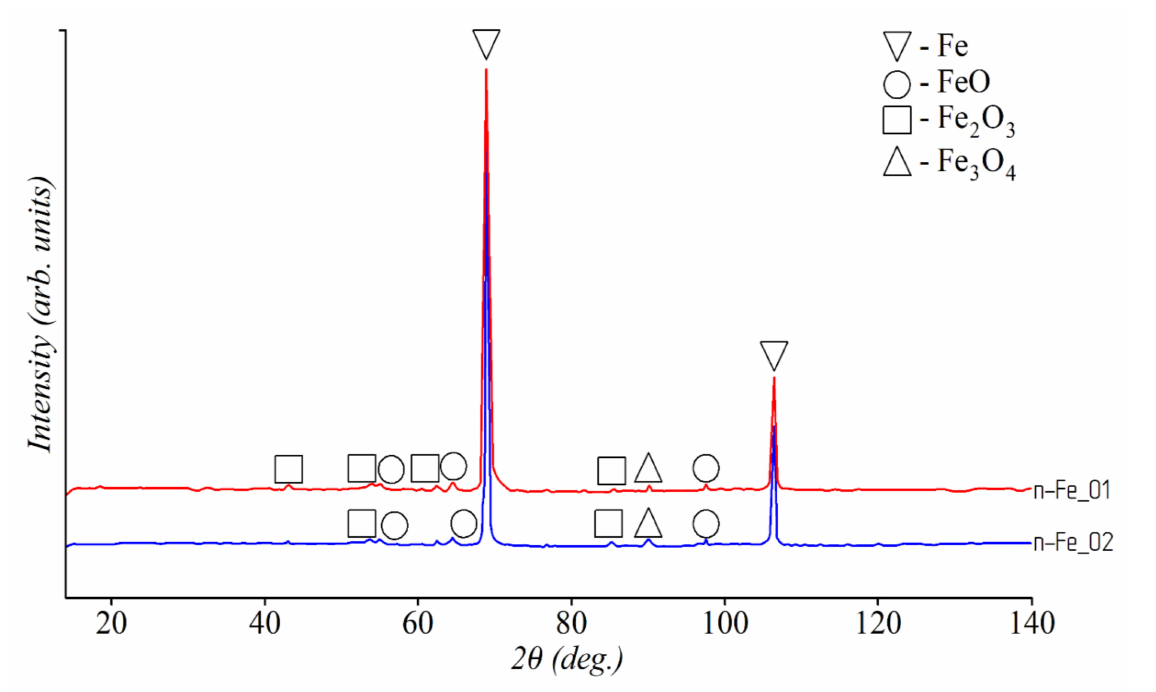
Figure 2. XRD patterns of n-FeO_01 and n-FeO_02 samples. The results of TEM analysis (see Figure 3) demonstrated that the Fe(n–Fe 2 O 3 _01) sam- ple consisted of nanoparticles agglomerates about 100 nm in size, which were surrounded by an oxide shell. These agglomerates had dissimilar fraction size. Both large and small fractions of about 75 nm and 20 nm, respectively, were detected. The same was detected in the case of Fe(n-Fe(OH) 3 ) sample (see Figure 3b), while the Fe(n–FeO_01) sample was a highly aggregated powder consisting of fine particles with an average size of 100–200 nm (see Figure 3c).